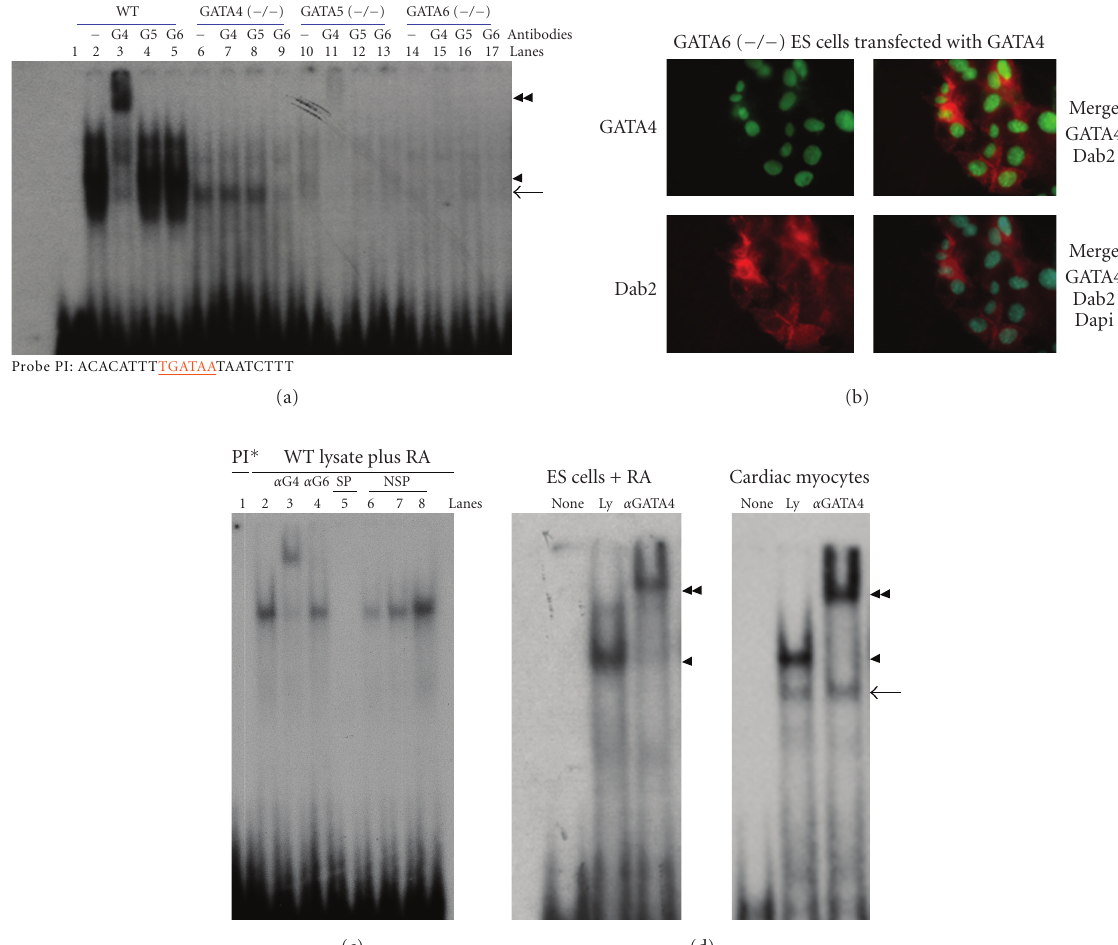
Figure 4: GATA-binding activity in retinoic acid-induced endoderm di ff erentiation of wildtype and GATA-deficient ES cells. Wild type ES cells and those homozygous deficient in GATA4, GATA5, or GATA6 were treated with retinoic acid (1 μ M) for 4 days. Nuclear extracts of the ES cells were used for EMSA and supershifted with antibodies specific for each GATA factor. (a) For EMSA, the labeled Dab2-PI GATA binding probes were incubated with nuclear extracts from ES cells treated with retinoic acid (1 μ M) for 4 days. GATA6 (arrow) and GATA4 (arrowhead) containing complexes are indicated. The supershifted GATA4-containing complexes are indicated by a double- arrowhead. (b) GATA6 ( − / − ) ES cells in monolayers were transfected with GATA4 and immunofluorescence stainings of Dab2 (red) and GATA4 (green) were observed by fluorescence microscopy. DAPI (blue) was used for nuclear counter staining. (c) The binding to the PI probe is compared between nuclear extracts from retinoic acid-treated ES cells and cardiomyocytes. GATA4-containing (arrowhead), anti-GATA4 supershifted (double arrowhead), and GATA6-containing (arrow) complexes are indicated. Self competition (SP) assay was performed with nonradioactive PI probe and nonspecific competitions were performed with m1pI: PI probe with mutation in GATA binding site 1 (lane 6); with m2pI: PI probe with mutation in GATA binding site 2 (lane 7), and m1pI/m2 m2pI: probe PI with mutations in both GATA binding sites (lane 8). α G4 and α G6: antibodies against GATA4 and GATA6; SP: self competition with cold PI; NSP: nonspecific